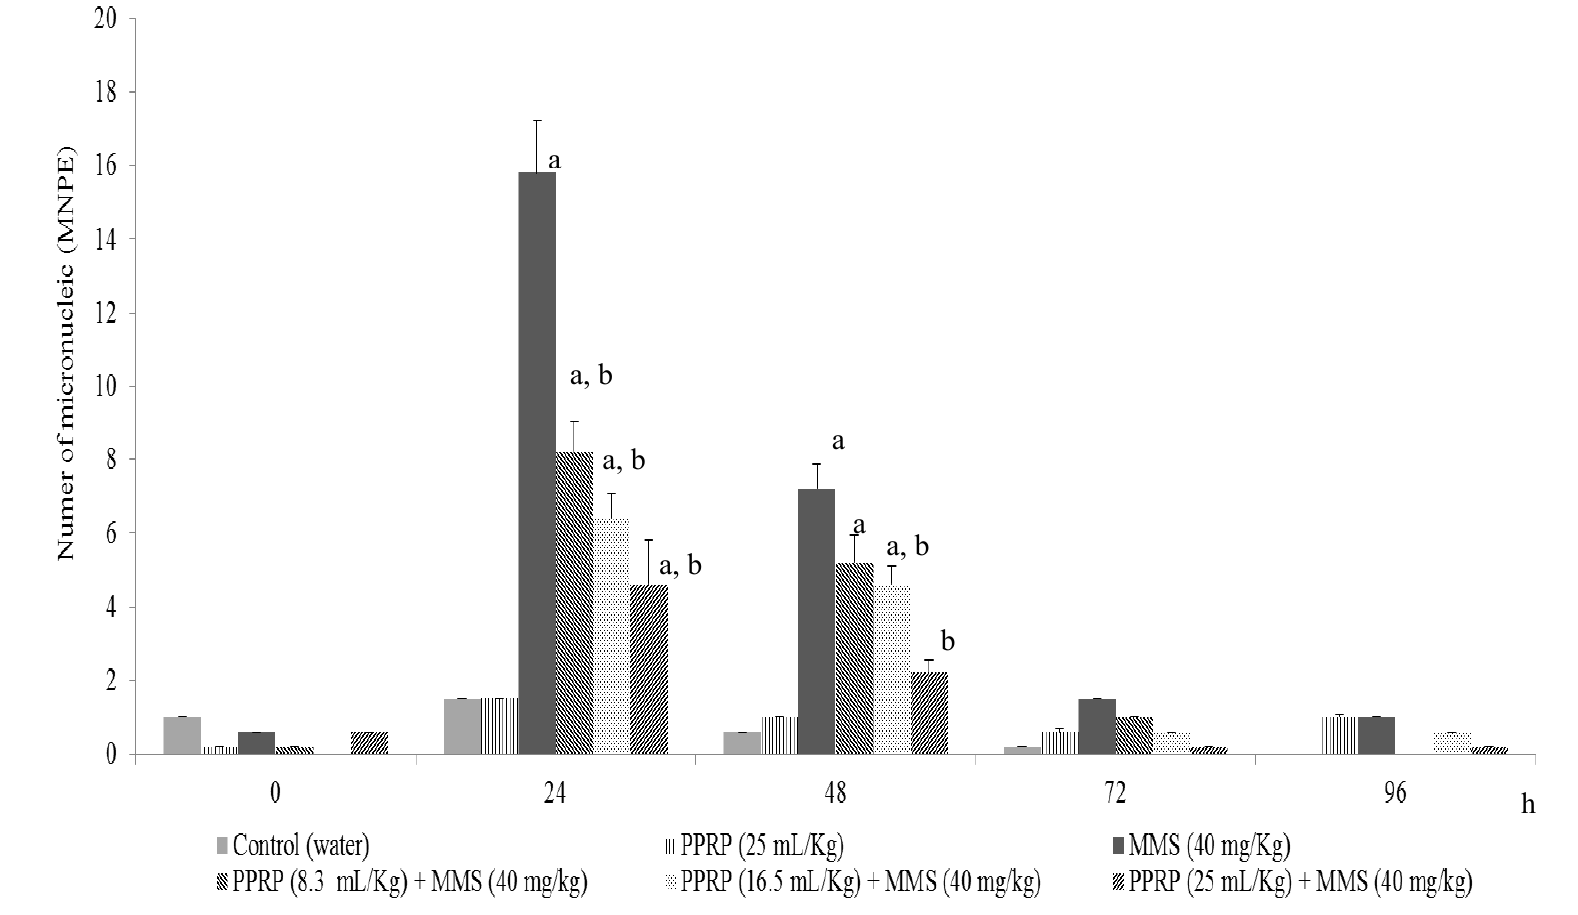
Figure 2. Frequency of micronucleated polychromatic erythrocytes (MNPE) in mice treated with juice of prickly pear variety red-purple (PPRP) and methyl methanesulfonate (MMS). Values represent the mean ± SD of six mice per group. The superscript letters show statistically significant differences as follows: a with respect to the control value; and b with respect to the value in the group treated with MMS. Anova and Student t tests ( p ≤